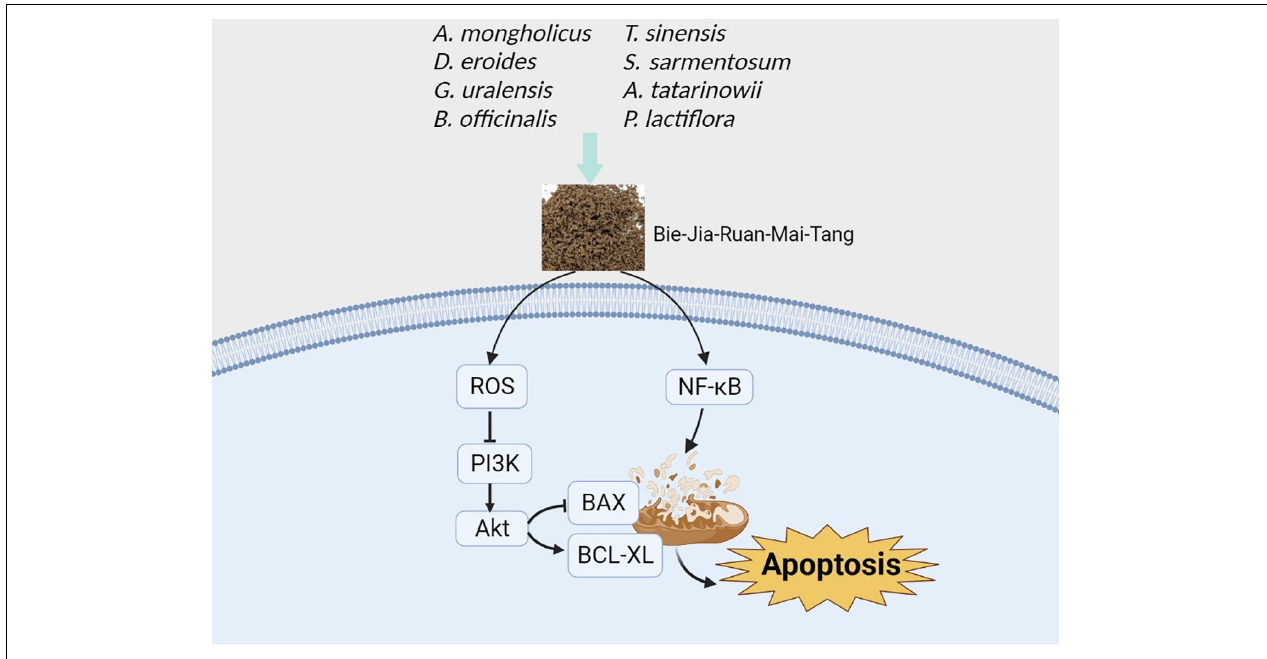
FIGURE 9 | Suggested mechanism of action of BJ eliciting the apoptosis of HRCECs exposed to high glucose. Created with